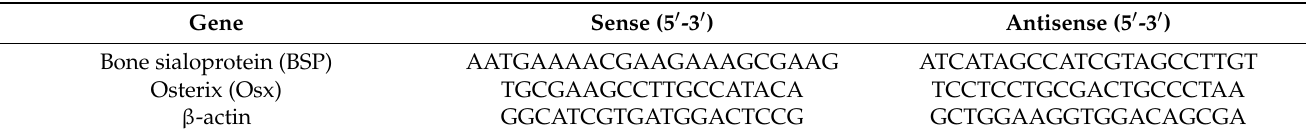
Table 3. Primer sequence used in quantitative PCR